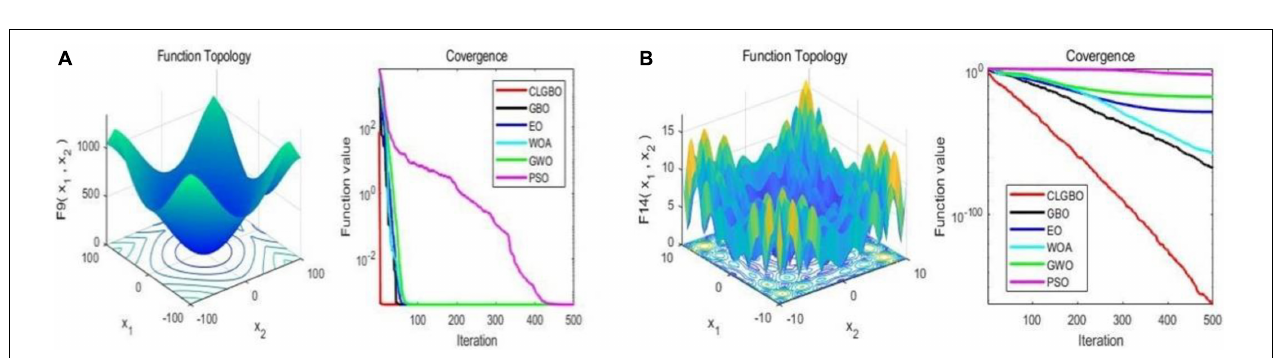
FIGURE 3 | 3D representation and convergence curve of two unimodal functions. (A) the result of the function F3. (B) the result of the function F6.